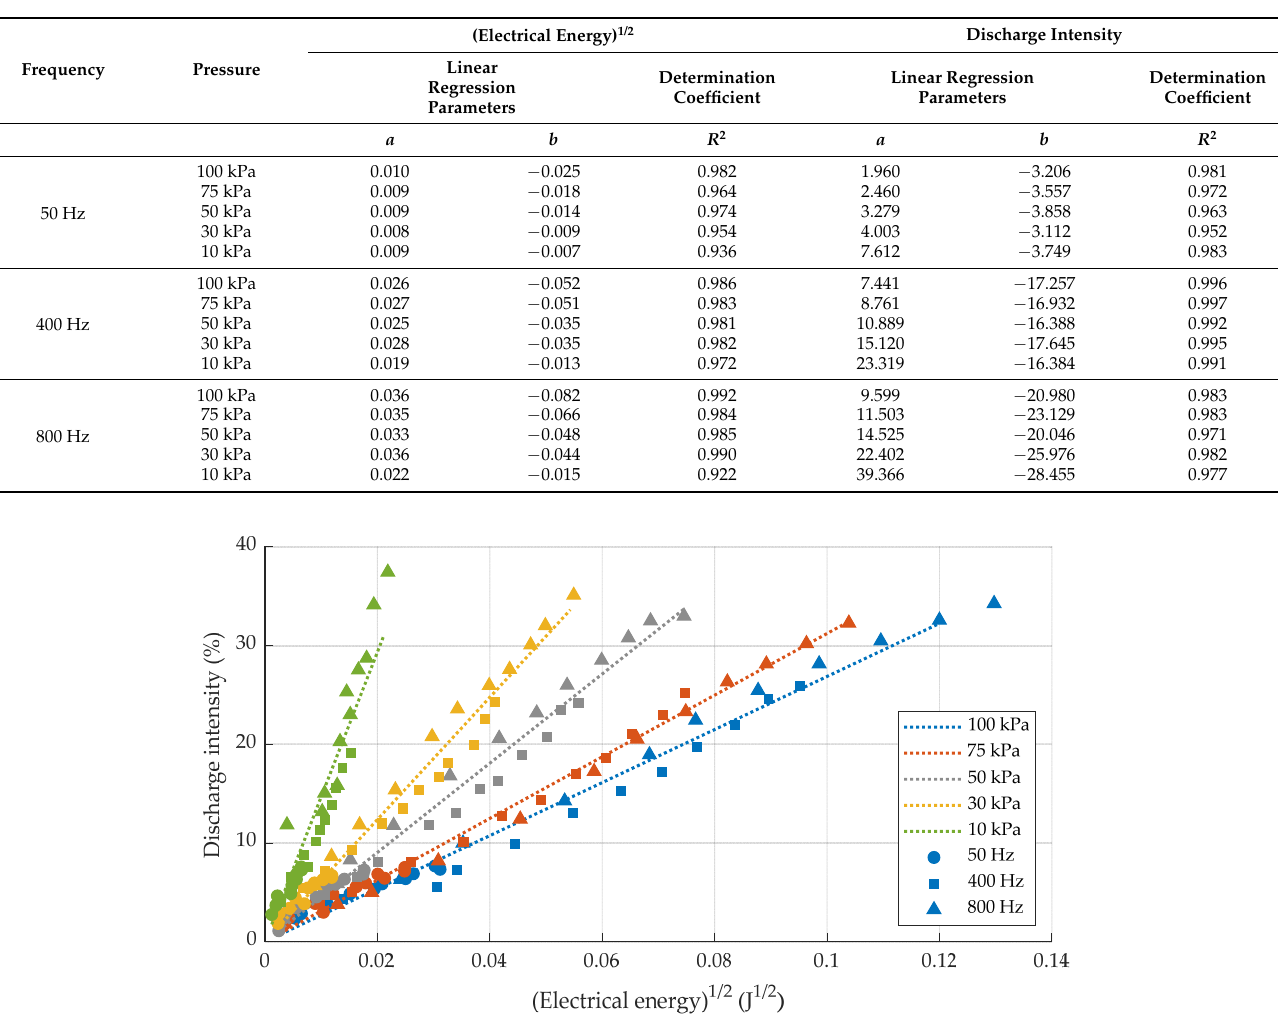
Figure 9. Normalized intensity versus the electrical energy of the discharges for air pressures ranging from 10 to 100 kPa and at 50, 400, and 800 Hz frequencies. Table 3 summarizes the main parameters of the linear regression between the nor- different pressures analyzed in the range of 100–10 kPa. The results presented in Table 3